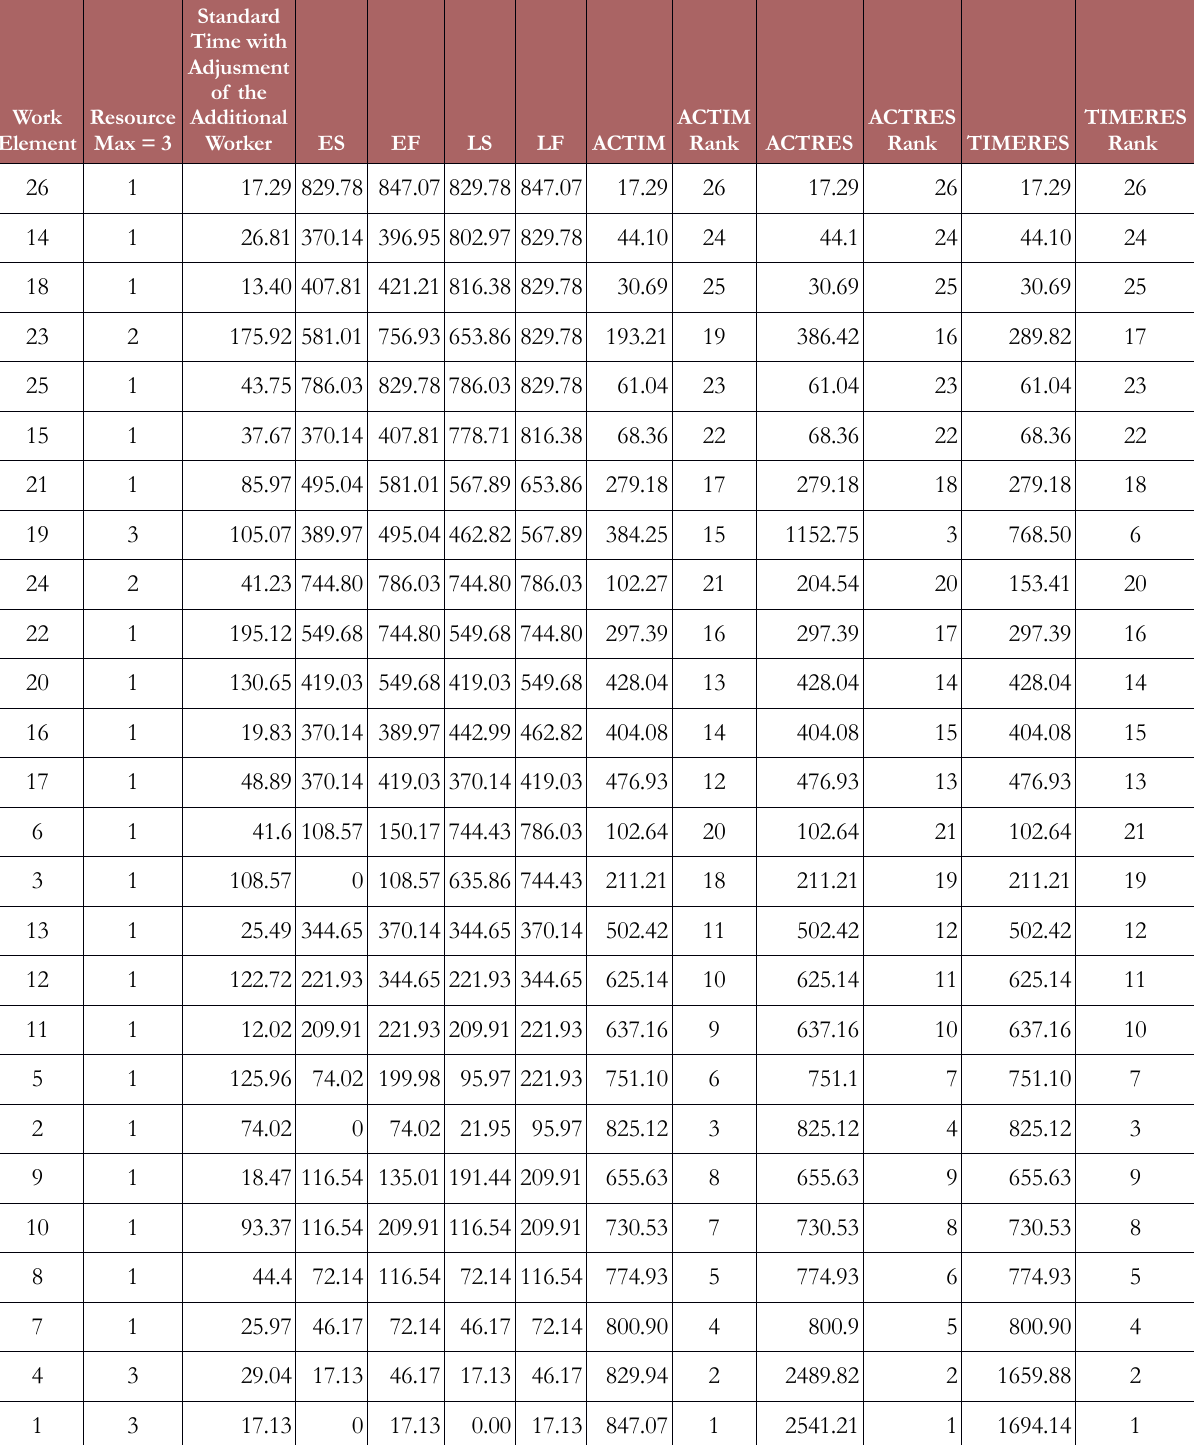
Table 9. Calculation of ES, LS, EF, LF, ACTIM, ACTRES, and TIMRES for Rmax =